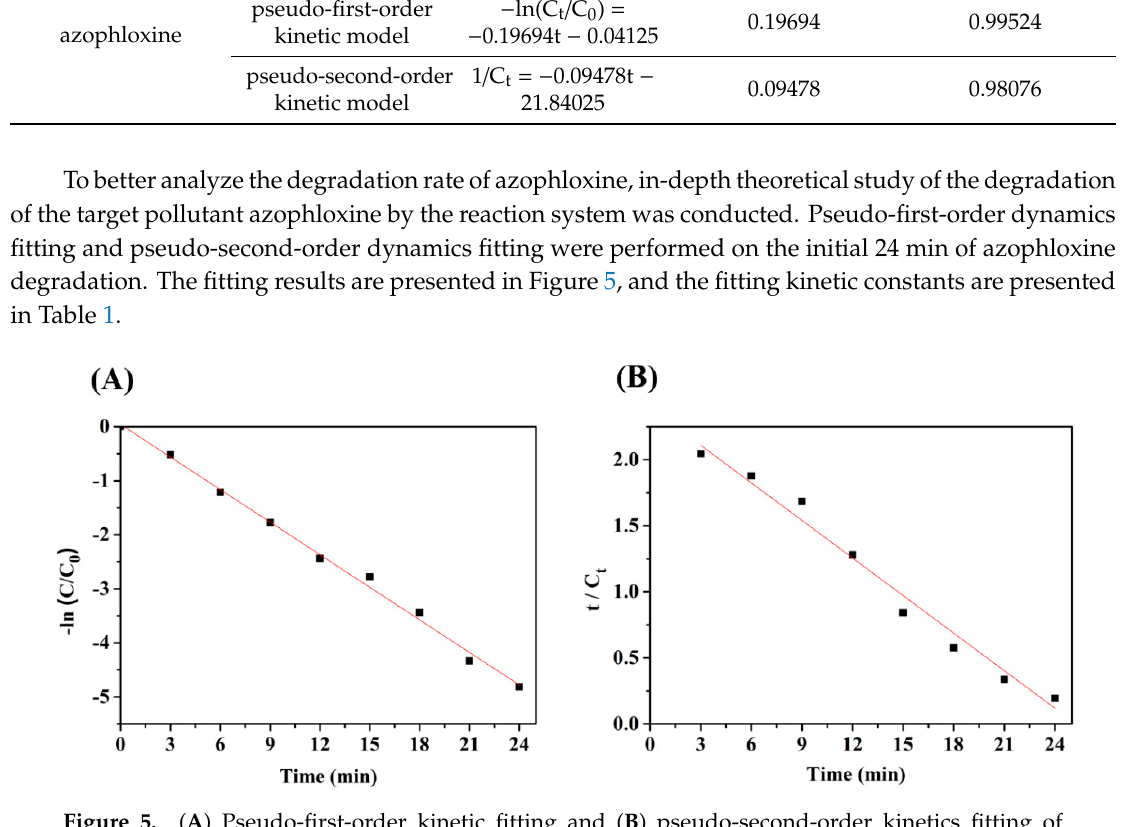
Figure 5. ( A ) Pseudo-first-order kinetic fitting and ( B ) pseudo-second-order kinetics fitting of azophloxine degradation. Reaction conditions: [PMS] = 5 mmol/L, T = 25 °C, pH = 6. Other chemical reagents used: [FeAlg-ACF] = 2 g/L, [azophloxine] = 50 μ mol/L. Table 1. Kinetic constants of azophloxine degradation by the FeAlg-ACFs/PMS/visible light system.